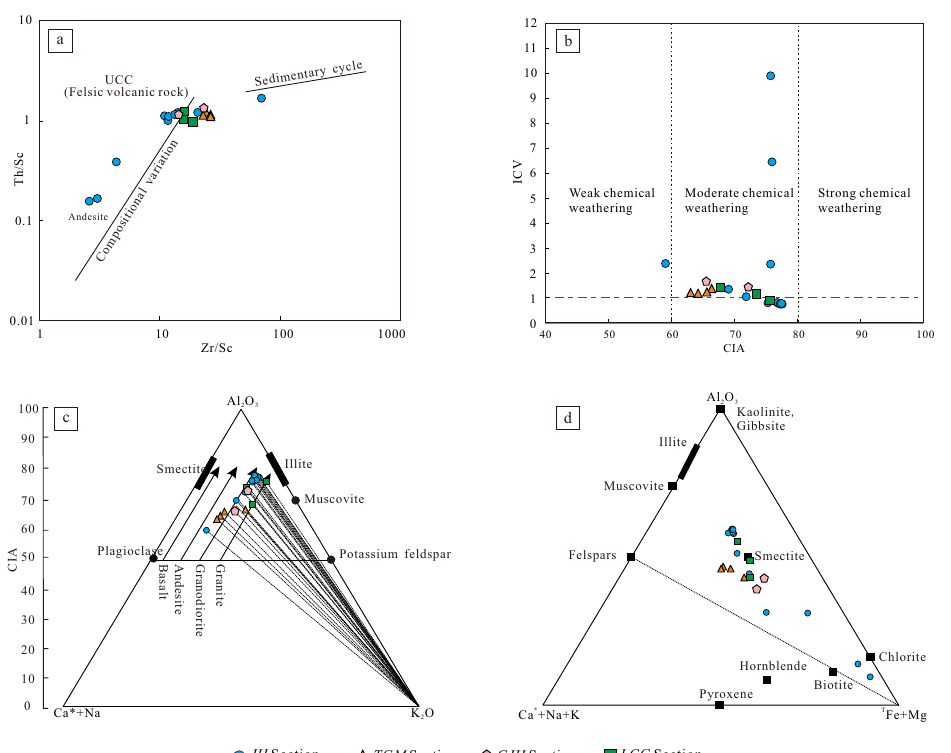
Figure 12. Discrimination map of the chemical weathering degree of the Xu-3 Member. ( a ) ICV- CIA related diagrams; ( b ) Th/Sc-Zr/Sc diagrams (after [88]); ( c ) A-CN-K diagrams (after [89]); ( d ) A-CNK-FM diagrams (after [77]) (CJH and LCG data from